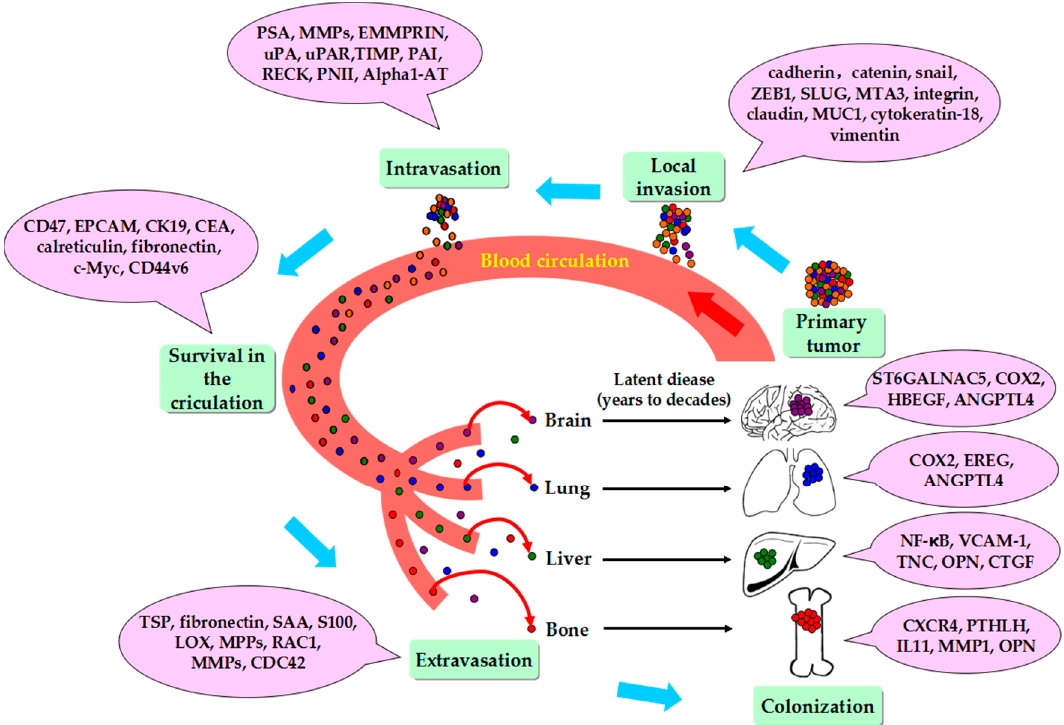
Figure 3. Simplified summarizes of metastatic cascade of breast cancer and genes involving in the process of metastasis. Cancer-driven events in the metastatic cascade are delineated in time and space in a counter-clockwise beginning with the primary cancer, and then intravasation into the blood circulation, active or passive migration toward the target organ, embedding into a capillary bed, attachment to the endothelium, and extravasation, which leads to infiltration into the underlying tissue, and expansion in the target microenvironment. MMPs, matrix metalloproteinases; ZEB1, zinc finger E-box-binding homeobox 1; SLUG, zinc finger protein SNAI2; MTA3, metastasis-associated protein; MUC1: mucin 1, cell surface-associated; PSA, prostate-specific antigen; EMMPRIN: extracellular matrix metalloproteinase inducer; uPA: urokinase plasminogen activator; uPAR: urokinase plasminogen activator receptor; PAI: plasminogen activator inhibitor; RECK: reversion-inducing cysteine-rich protein with kazal motifs; PN-II: protease nexin-II; alpha1-AT: alpha 1-antitrypsin; EPCAM, epithelial cell adhesion molecule; CK19, Cytokeratin 19; CEA, carcinoembryonic antigen; SAA, serum amyloid A; LOX, protein-lysine 6-oxidase; RAC1, Ras-related C3 botulinum toxin substrate1; cdc42, cell division control protein 42 homolog; ST6GALNAC5, AGPTL4: promoting seeding; promoting colonization: OPN, CXCR4; COX-, CXCL12/CXCR4: proinflammatory molecules and chemokines/receptors; VCAM-1, TNC, OPN: adhesion and extracellular matrix molecules; SRC, NF- κ B: intracellular signaling proteins. The data adapted from the study of Bos and Zhou [8,14].